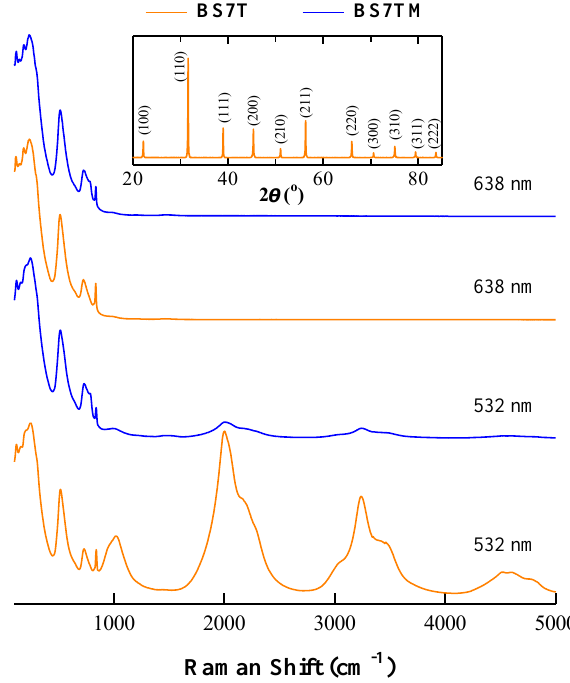
Figure 6. Room temperature Raman spectra of BS7T and BS7TM ceramics excited by 532 and 638 nm lasers. The inset shows the XRD pattern of BS7T.